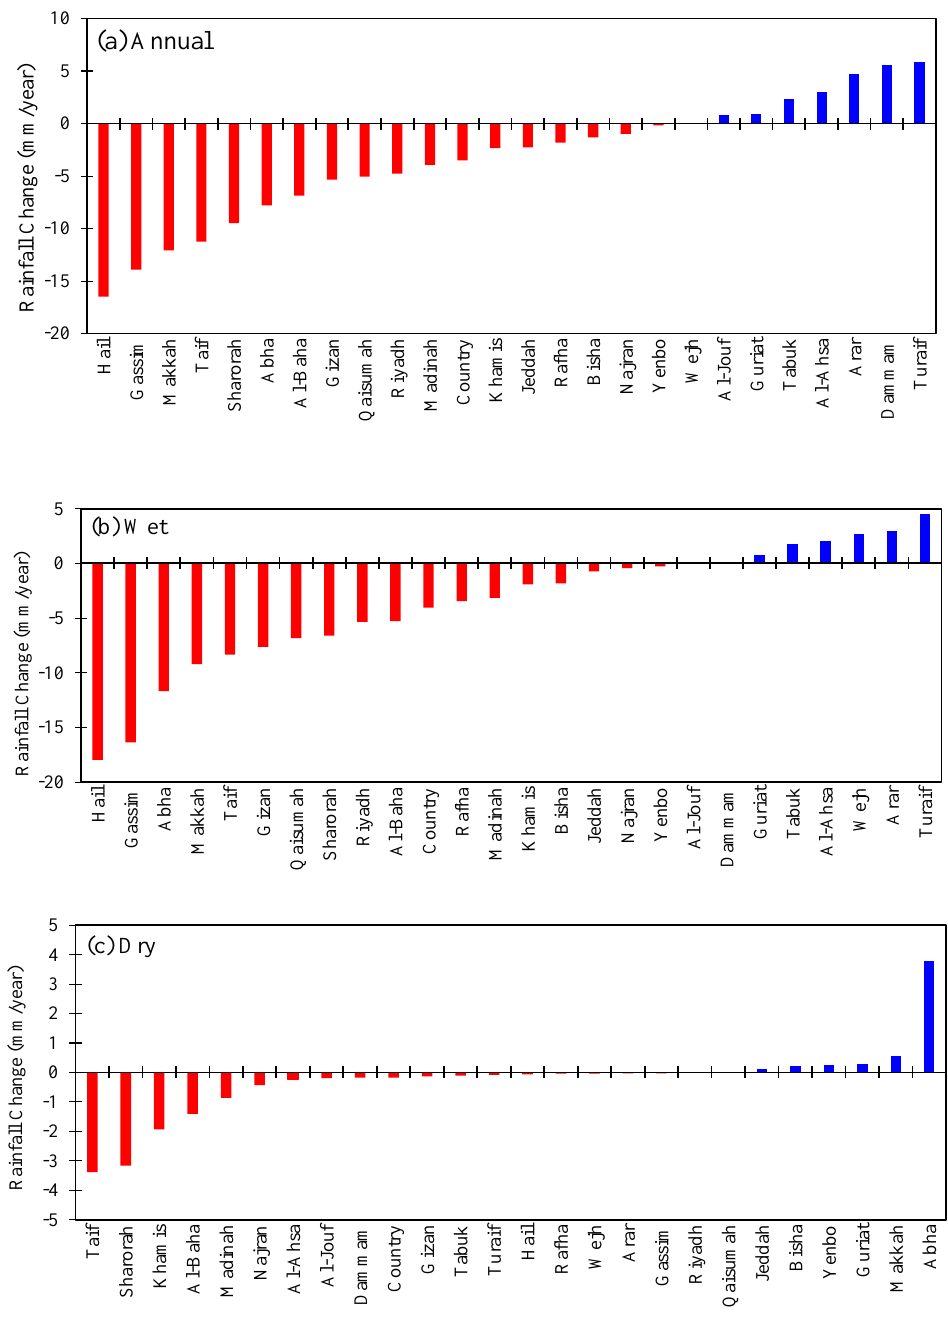
Figure 6. Changes in rainfall at 25 stations and over the entire country for ( a ) annual, ( b ) wet season (October–May), and ( c ) dry season (June–September) with respect to base period 1981–2010 averaged for the period 1978–2019. The blue and red bars indicate positive and negative changes, respectively. The scales on the vertical axes are not the same for all panels. The station locations in di ff erent climate zone can be seen in Table